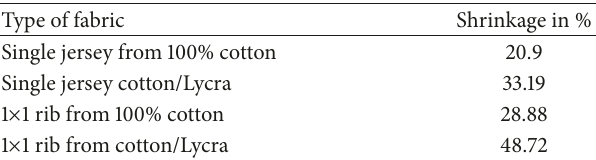
Table 11: Widthwise shrinkage of single jersey and 1 × 1 rib knitted